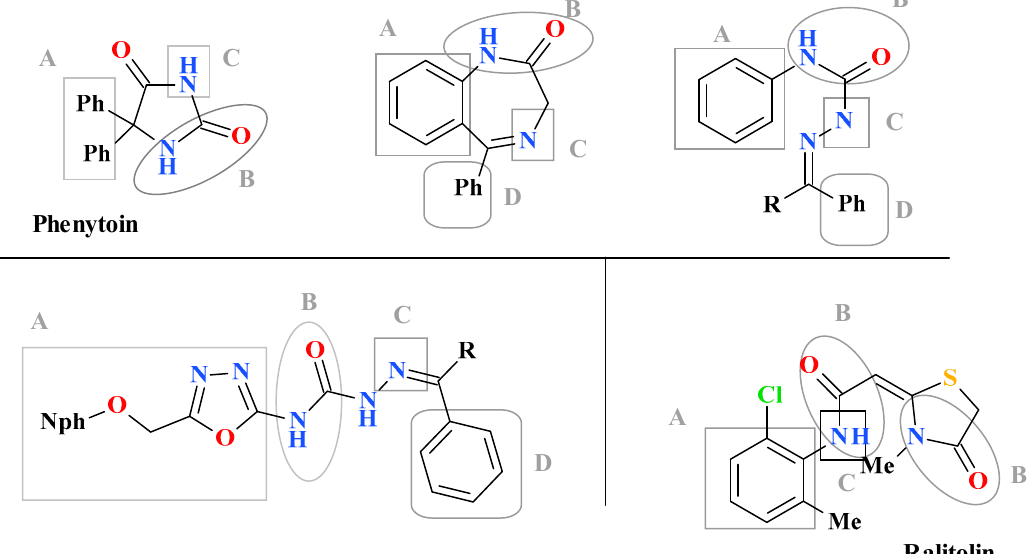
Figure 1. Structural features and “pharmacophore fragments” of the known anticonvulsants (fragments containing hydrophobic aromatic systems ( A ), a hydrogen-binding domain ( B ), an electron-donor fragment ( C ), a distal aromatic ring ( D ) adapted from [22,26].